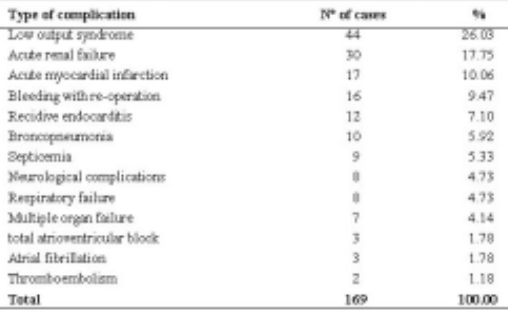
Table 3. Active infectious endocarditis: surgical treatment Complications in the post-operative